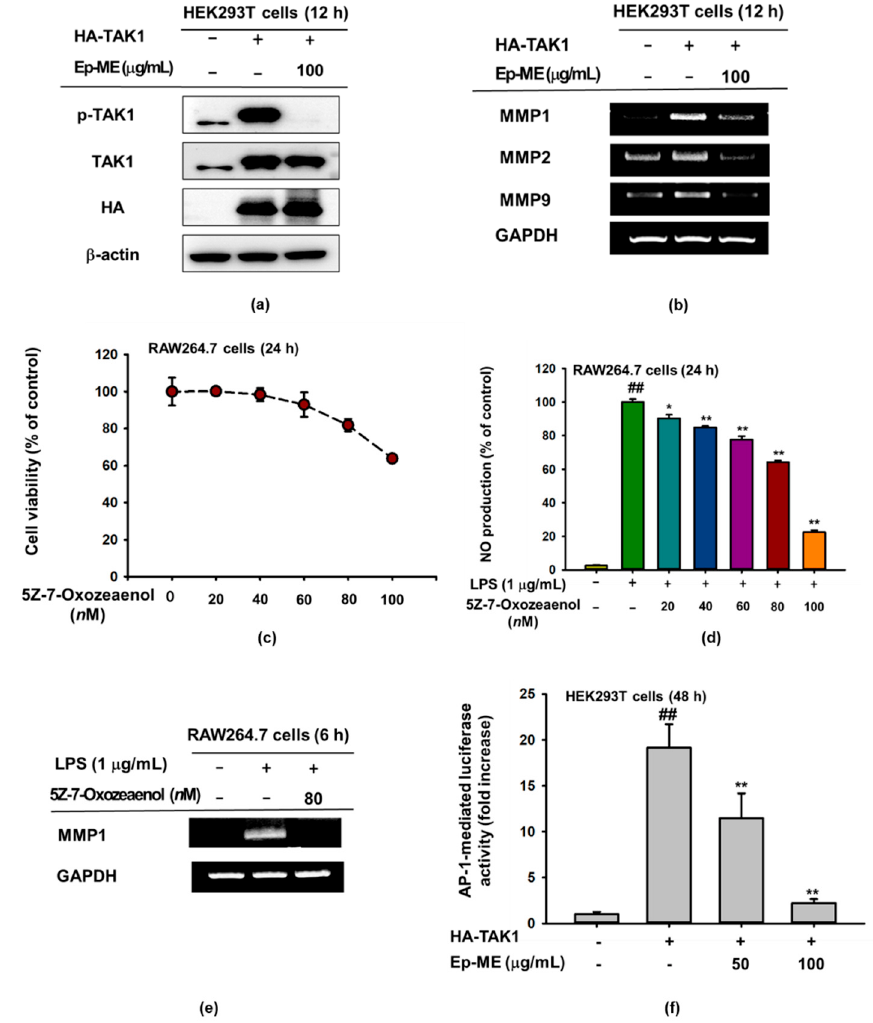
Figure 4. Anti-inflammatory e ff ects of Ep-ME by targeting TAK1 kinases. HEK293T cells were transfected with HA-TAK1, followed by treatment with Ep-ME for an additional 24 h. ( a ) HA, β -actin, and phosphorylated and total forms of TAK1 were examined by immunoblotting. ( b ) The mRNA expression levels of MMP1, GAPDH, MMP2, and MMP9 were assessed by RT-PCR in LPS-induced RAW264.7 cells after treatment with Ep-ME. ( c ) Cytotoxic e ff ects of 5Z-7-oxozeaenol, a TAK1 inhibitor, against RAW264.7 cells after incubation for 24 h. ( d ) NO production was determined through the Griess assay in LPS-induced RAW264.7 cells after treatment with 5Z-7-oxozeaenol. ( e ) The mRNA expression levels of MMP1 and GAPDH were assessed through RT-PCR. ( f ) HEK293T cells transfected with HA-TAK1 plasmid were transfected with AP-1-Luc for 24 h, followed by treatment with Ep-ME for an additional 24 h. The data presented in ( a , b , e ) are representative of three independent experiments. ## p < 0.01 vs. untreated control group, * p < 0.05, and ** p < 0.01 vs. control